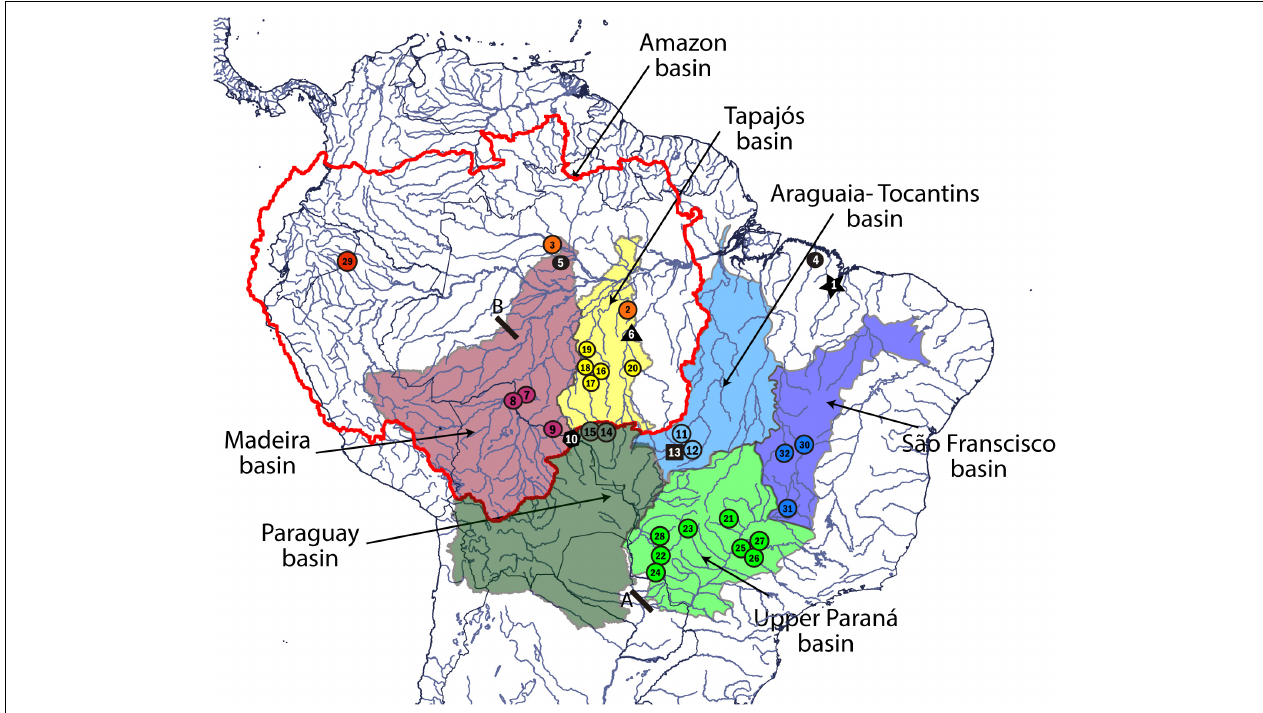
FIGURE 1 | Collection sites and hydrographic basin of occurrence of Leporinus cf. friderici . Colored circles represent the MOTUs found in this study: L. agassizii (red), L. cf. friderici Amazon 1 (orange), L. cf. friderici Madeira 1 (purple), L. cf. friderici Paraná (light green), L. cf. friderici Paraguay (dark green), L. piau São Francisco (dark blue), L. cf. friderici Upper Tapajós (yellow), and L. cf. friderici Tocantins 1 (light blue). Black dot represents individuals collected as L. cf. friderici Amazon 2; black star represents L. cf. friderici Mearim; black square represents L. cf. friderici Tocantins 2; black polygon represents L. cf. friderici Madeira 2; black triangle represents L. cf. friderici Xingú. A, Prior Sete Quedas waterfalls region and Itaipú dam. B, Teotônio falls in the Madeira River. Map created by Q-GIS (http://www.qgis.org/). The collection site numbers are according to Supplementary Table S1